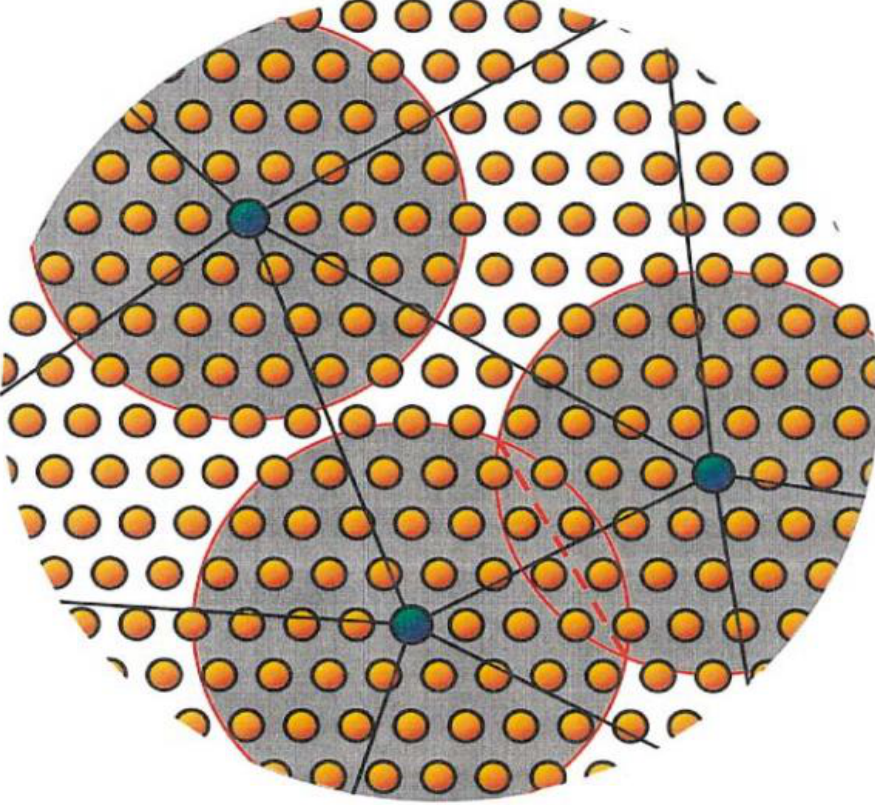
Figure 3. Illustration of non-local QC formulation with overlapping crystallites. Reproduced with permission from [49].